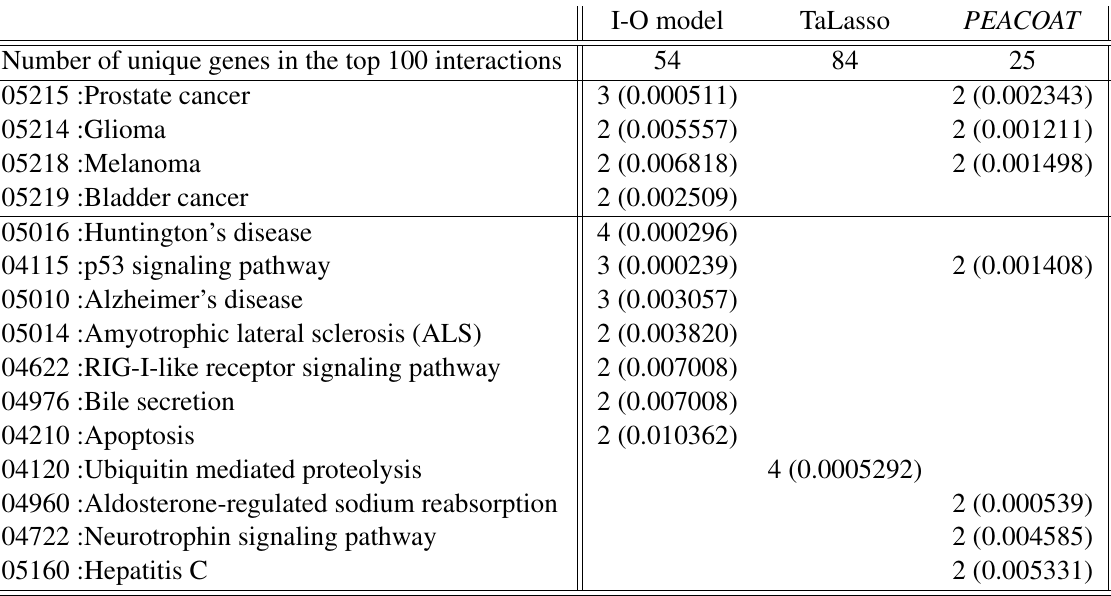
Table 3: Enriched KEGG pathways among genes in the top 100 interactions The top row gives the number of unique genes present in the top 100 miR-mRNA interactions according to each model; the remaining rows give, per column, the number of these genes annotated by KEGG pathway terms with significant enrichment (FDR corrected p < 0 . 05 ) for each of the models. The [uncorrected] hypergeometric p-value is given in parentheses. A blank entry indicates that the particular pathway was not significantly enriched in the model. Cancer-related KEGG pathways are shown at the top of the table, with other enriched pathways